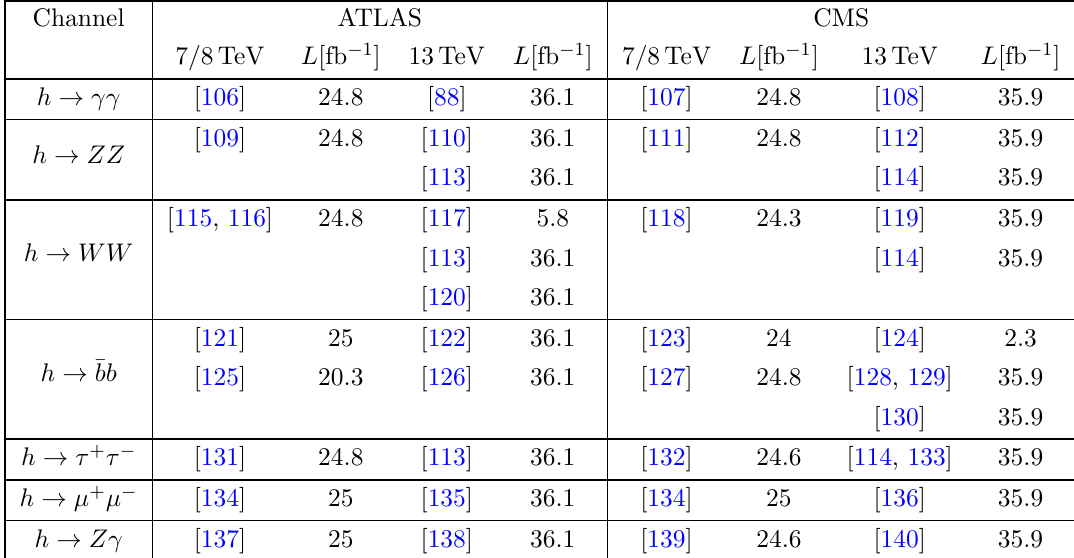
h ! (cid:28) + (cid:28) (cid:0)